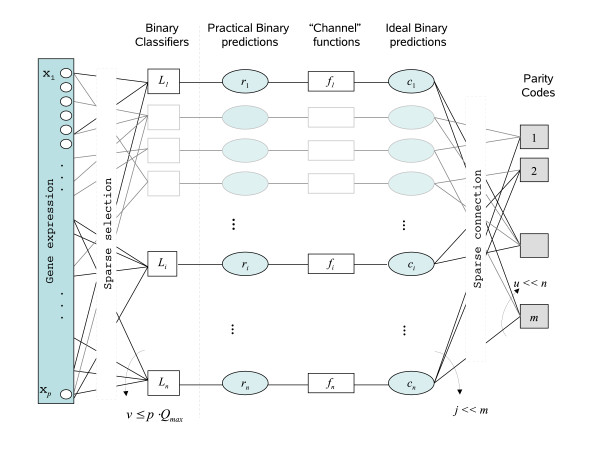
The architecture of an ECOC-LDPC classifier under bounded gene selection. Right squares represent constituent ECOC classifiers induced from simple parity codes, left squares represent practical binary classifiers, rectangles represent "channel" functions, ellipses represent binary predictions, and small circles represent gene expression measurements. Edges are put between constituent ECOC classifiers and ideal binary predictions ci taking care that the connectivity profile remains sparse (j < <m, u < <n). Ideal binary predictions ci and practical ones ri are constrained by "channel" functions fi modeling prior statistical knowledge about binary classifiers errors, i = 1,..., n. Each practical binary classifier Li selects a subset of v genes from a pool of p genes taking care that no more than ⌈log2M⌉n⋅H(1p) genes get selected.